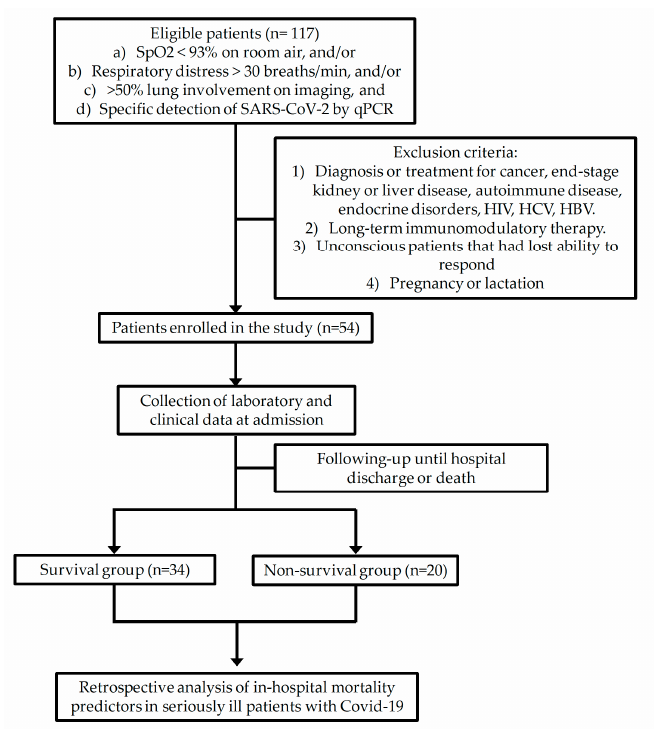
Figure 1. Schematic flow chart showing the selection process of patients enrolled in the study based on the inclusion and exclusion criteria. SpO 2 , oxygen saturation level; SARS-CoV-2, novel severe acute respiratory syndrome coronavirus-2; qPCR, quantitative polymerase chain reaction; HIV, human immunodeficiency virus; HCV, hepatitis C virus; HBV, hepatitis B virus; Covid-19, coronavirus disease 2019.